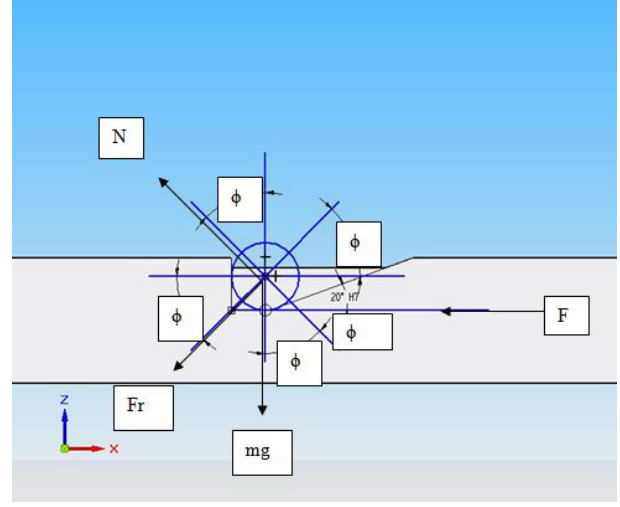
Figure 9. Scheme of equilibrium of forces to determine the horizontal force needed to elevate one